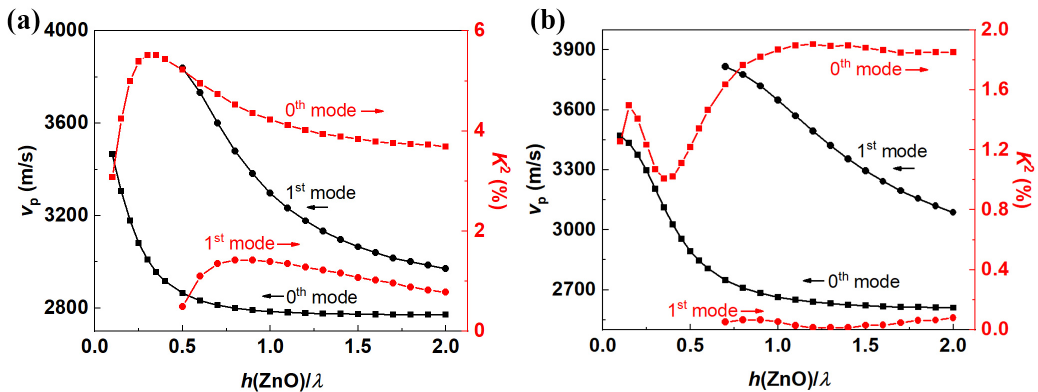
Figure 3. v p and K 2 of Love-mode waves ( a ) and Rayleigh-mode waves ( b ) as functions of h (ZnO) in the SAW devices based on the a-ZnO/a-GaN structure.